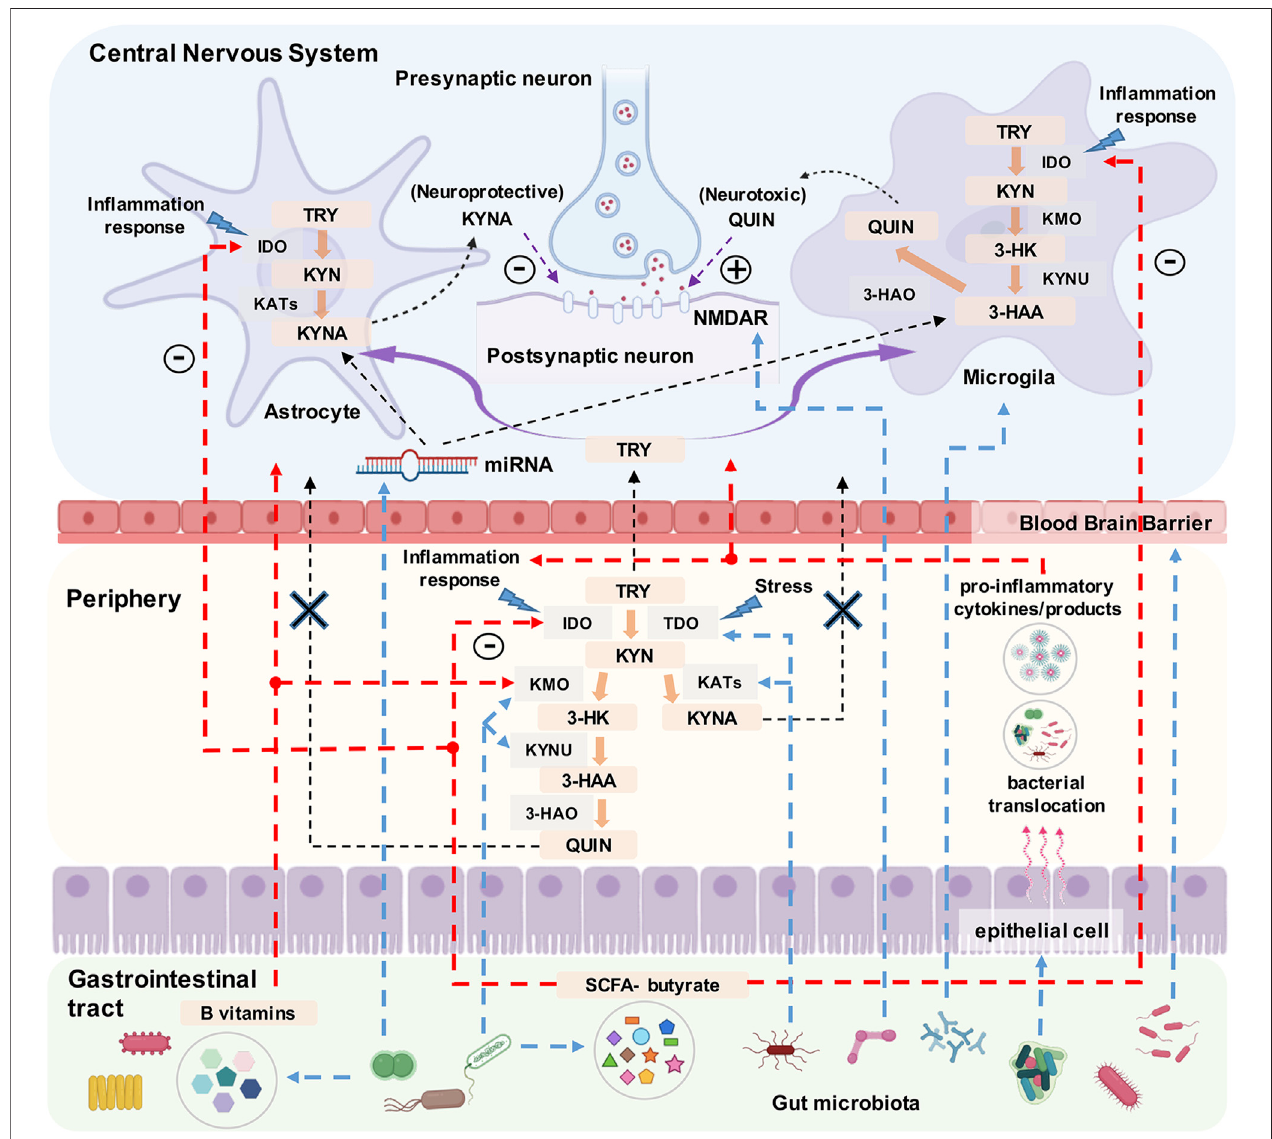
FIGURE 1 | The balance between kynurenic acid (KYNA) and quinolinic acid (QUIN) in the central nervous system and the critical impact points (presented as blue dotted lines) on the kynurenine pathway (KP) under the control of the gut microbiota. Note. TRY: tryptophan, KYN: kynurenine, 3-HK: 3-hydroxykynurenine, KYNA: kynurenic acid, 3-HAA: 3-hydroxyanthranilic acid, QUIN: quinolinic acid, IDO: indoleamine 2,3-dioxygenase, TDO: tryptophan dioxygenase, KATs: kynurenine aminotransferases, KMO: kynurenine-3-monooxygenase, KYNU: kynureninase, 3-HAO: 3-hydroxyanthranlic acid oxygenase, NMDAR: N-methyl- D -aspartate